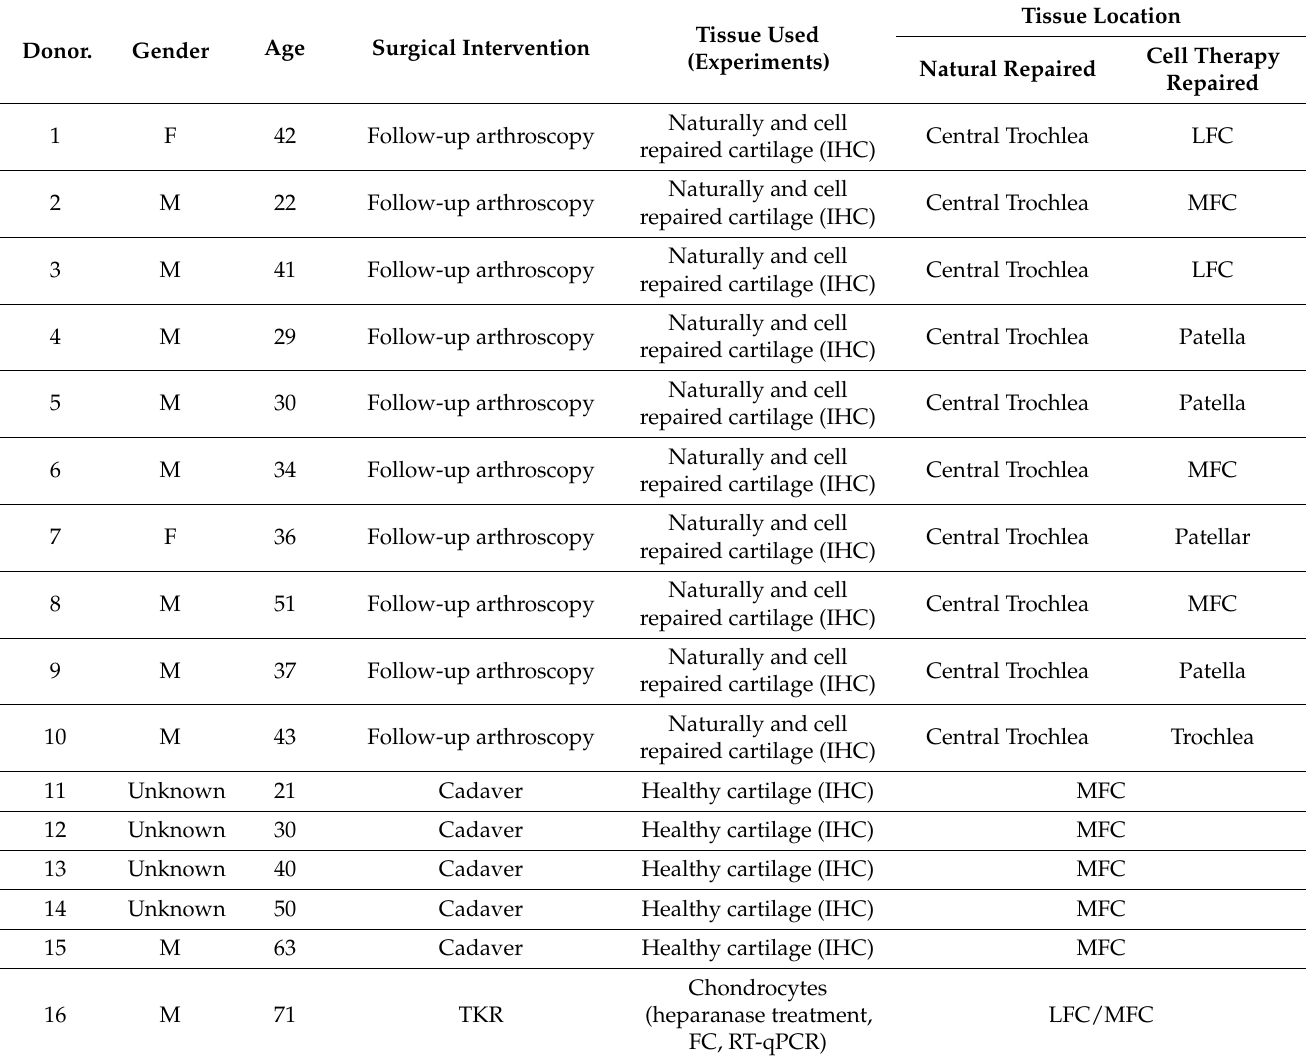
Table 1. Donor demographics and